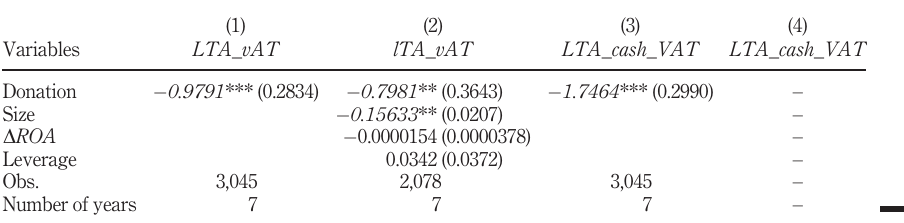
Table VII. Logistic